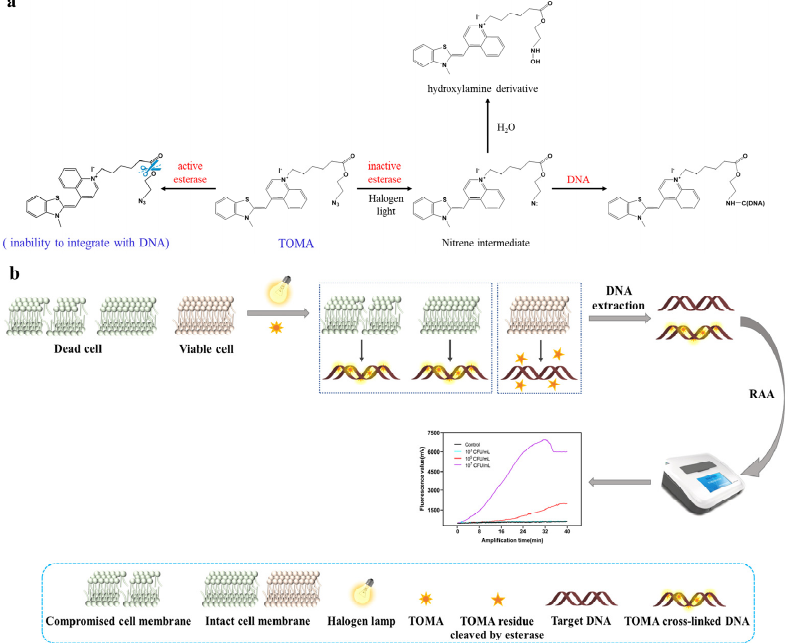
Figure 1. Working principle of the TOMA–RAA method for viable Salmonella detection. ( a ) The structure of the TOMA molecule and the process of TOMA integrating with DNA; ( b ) the detection process of the TOMA–RAA method for the specific detection of viable Salmonella .